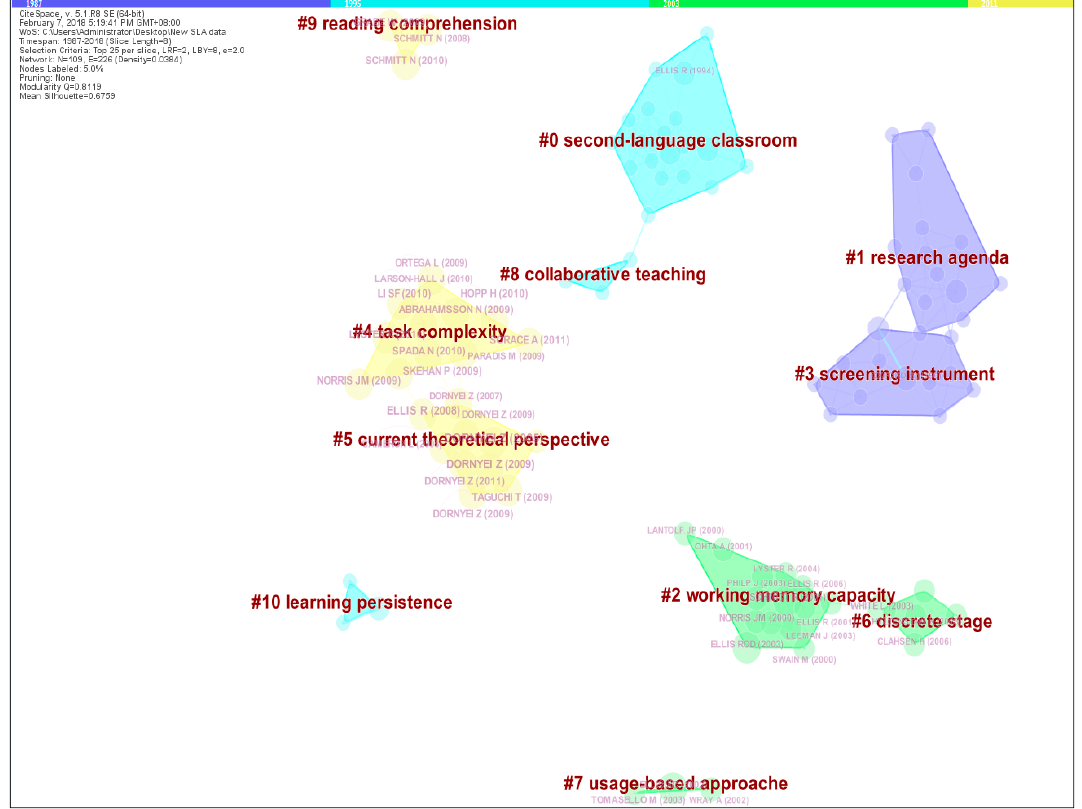
Figure 3. A clustered network of major research areas in SLA (1987–2018). Table 1. The summary of the 11 largest clusters.